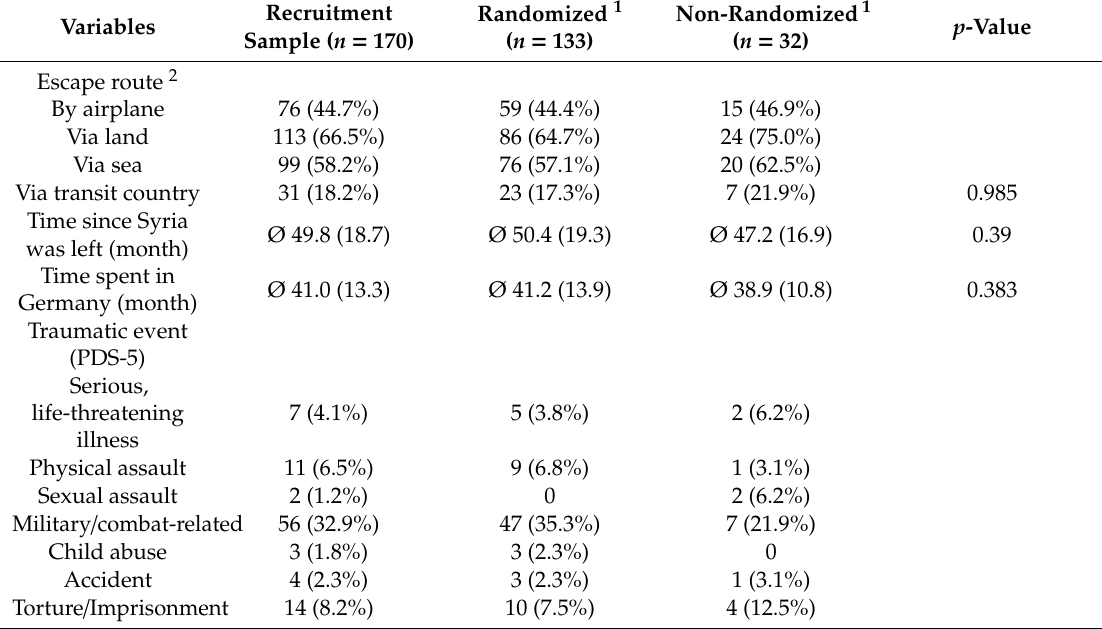
Table 2. Escape- and trauma-related characteristics of the recruitment sample screened for eligibility in the “Sanadak” trial with regard to randomization